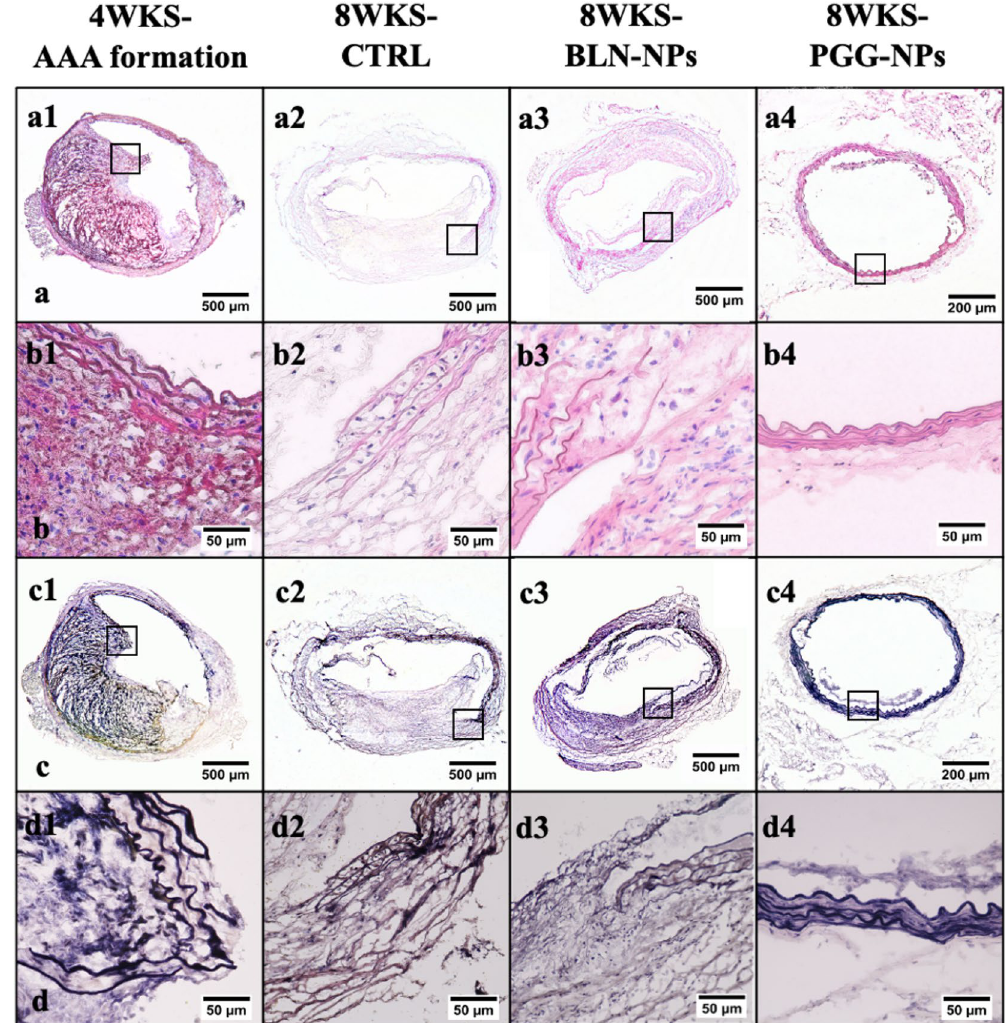
Figure 5. Histological analysis. ( a , b ) H&E staining for aneurysms; BLN-NPs, control and PGG-NPs groups are at lower (a1–4) and higher (b1–4) magnifications, showing the morphology and the cell infiltration of the suprarenal aortic tissue. The PGG-NPs group had better morphology and minimal cell infiltration compared to the other groups (the opening shown in a4 and d4 was a vessel branching out from the aorta); ( c , d ) VVG staining for aneurysms; BLN-NPs, control and PGG-NPs groups are at lower (c1–4) and higher (d1–4) magnifications, showing the elastin damage within the tissue. The elastic laminae in the PGG-NPs were repaired as compared to before therapy while in other groups they continued to